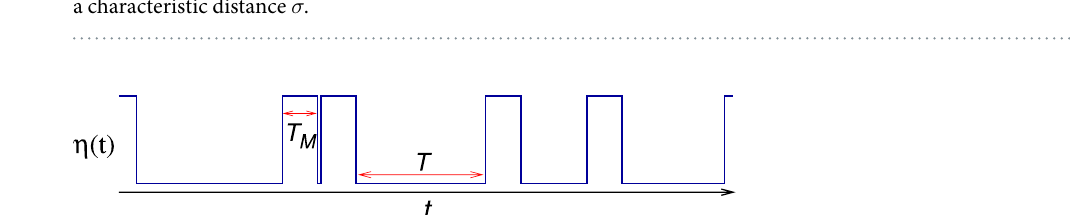
Figure 1. Section of the polymer translocating through a nanopore in 3d. The pore has a square section of width L H and its length is L M . Inside the pore it is present a driving force in the x -direction, which pushes the polymer toward the trans side of the membrane. The walls of the membrane repulse uniformly the chain inside a characteristic distance σ .